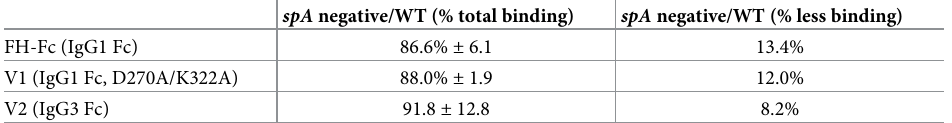
Table 2. Fusion protein binding to S . aureus strain Newman (WT) compared to S . aureus Newman Protein A defi- cient ( spA negative).